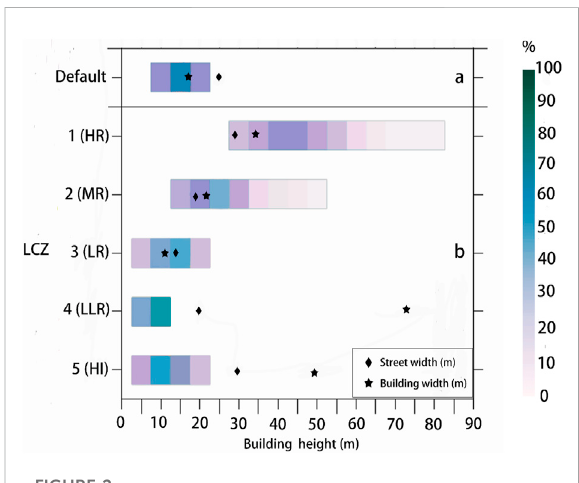
FIGURE 2 Urban form parameters of the (A) default urban canopy and (B) localized urban canopy. Bars represent the probability distributions of building height (unit: m); circles and asterisks represent street width (unit: m) and building width (unit: m),